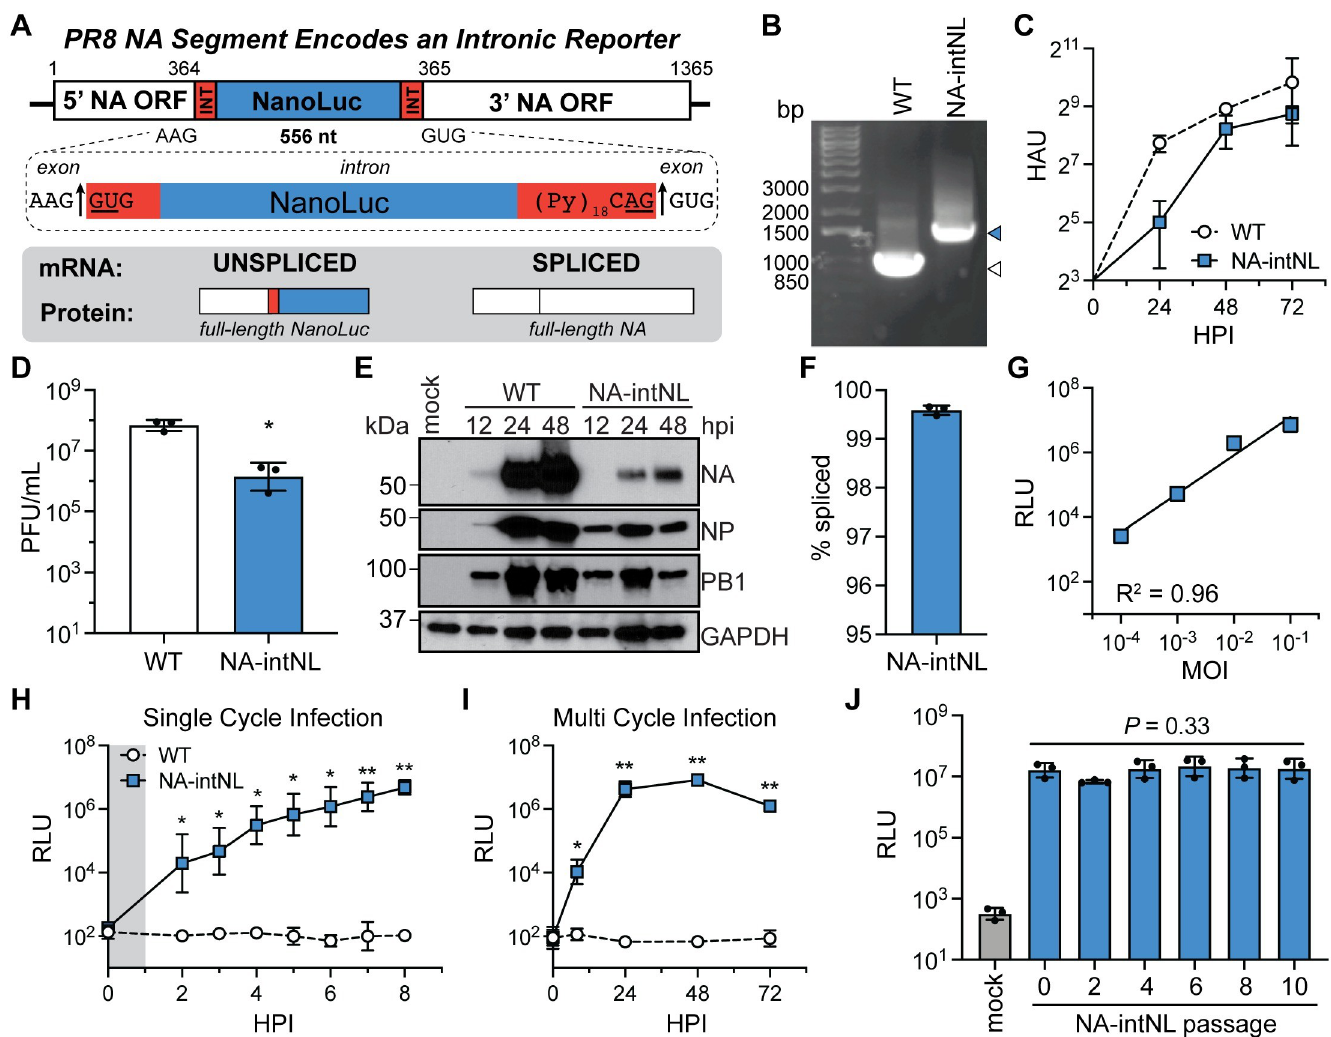
Fig 3. Artificial introns can be used for expression of a reporter protein. (A) Diagram of the PR8 IAV segment 6/NA containing an intron encoding a NanoLuc (NL) reporter and its protein products. (B) RT-PCR of WT PR8 virus (white) and PR8-NA-intNL virus (blue) segment 6/NA. (C) Growth kinetics of WT PR8 and PR8-NA-intNL virus infections (MOI = 0.001, multicycle) on MDCK cells, measured using HA assays (mean with SD, n = 3 independent experiments). (D) End point titers of WT PR8 and PR8-NA-intNL virus infections (MOI = 0.01, multicycle, 72h) on MDCK cells, measured using plaque assays (mean with SD, n = 3 independent experiments, unpaired Student’s t-test). (E) Western blots for PR8 NA, NP and PB1 proteins from mock, PR8 WT, and PR8-NA-intNL virus infections (MOI = 0.01, multicycle) on MDCK cells (representative of three independent experiments). GAPDH was used as a loading control. (F) PR8 segment 6/NA-intNL mRNA splicing rates from PR8-NA-intNL virus infections (MOI = 2, single cycle, 8h) on MDCK cells, measured using two-step RT-qPCR (mean with SD, n = 3 independent experiments). (G) Luciferase levels from PR8-NA-intNL virus infections at different MOIs (single cycle, 8h) on MDCK cells (mean with SD, n = 3 independent experiments, simple linear regression with goodness of fit). MOI, multiplicity of infection; RLU, relative light units. (H) Luciferase levels from WT PR8 and PR8-NA- intNL single cycle virus infections (MOI = 0.1, single cycle) on MDCK cells (mean with SD, n = 3 independent experiments, unpaired Student’s t-test relative to WT). Gray shading indicates infection incubation period. (I) Luciferase levels from WT PR8 and PR8-NA-intNL multicycle virus infections (MOI = 0.001, multicycle) on MDCK cells (mean with SD, n = 3 independent experiments, unpaired Student’s t-test relative to WT). (J) Luciferase levels from infections (MOI = 0.001, multicycle, 24h) on MDCK cells using PR8-NA-intNL virus (passage 0) and supernatants from serial PR8-NA-intNL virus infections (MOI = 0.001, multicycle, 72h passages) on MDCK cells (mean with SD, n = 3 independent experiments, one-way ANOVA). For all panels: � P < 0.05, �� P < 0.001 and ns = not significant.